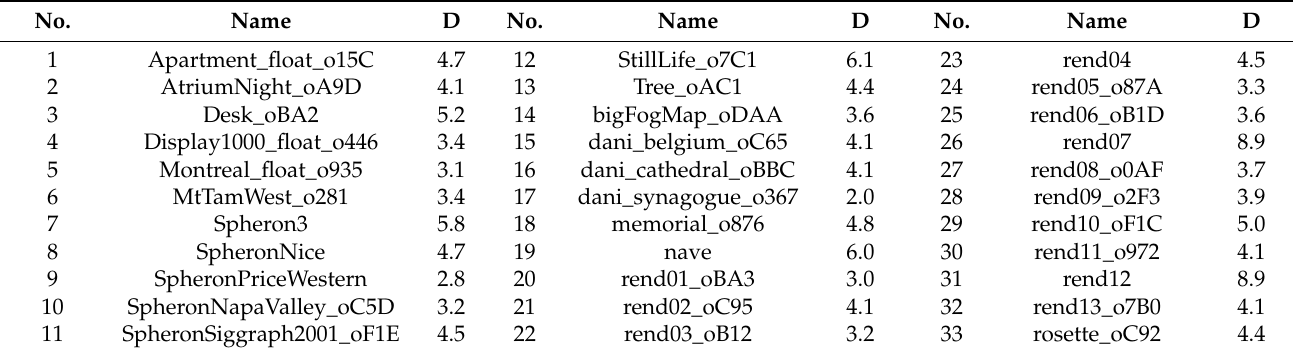
Table 1. List of 33 test images from the dataset from [29] and their dynamic ranges (D).